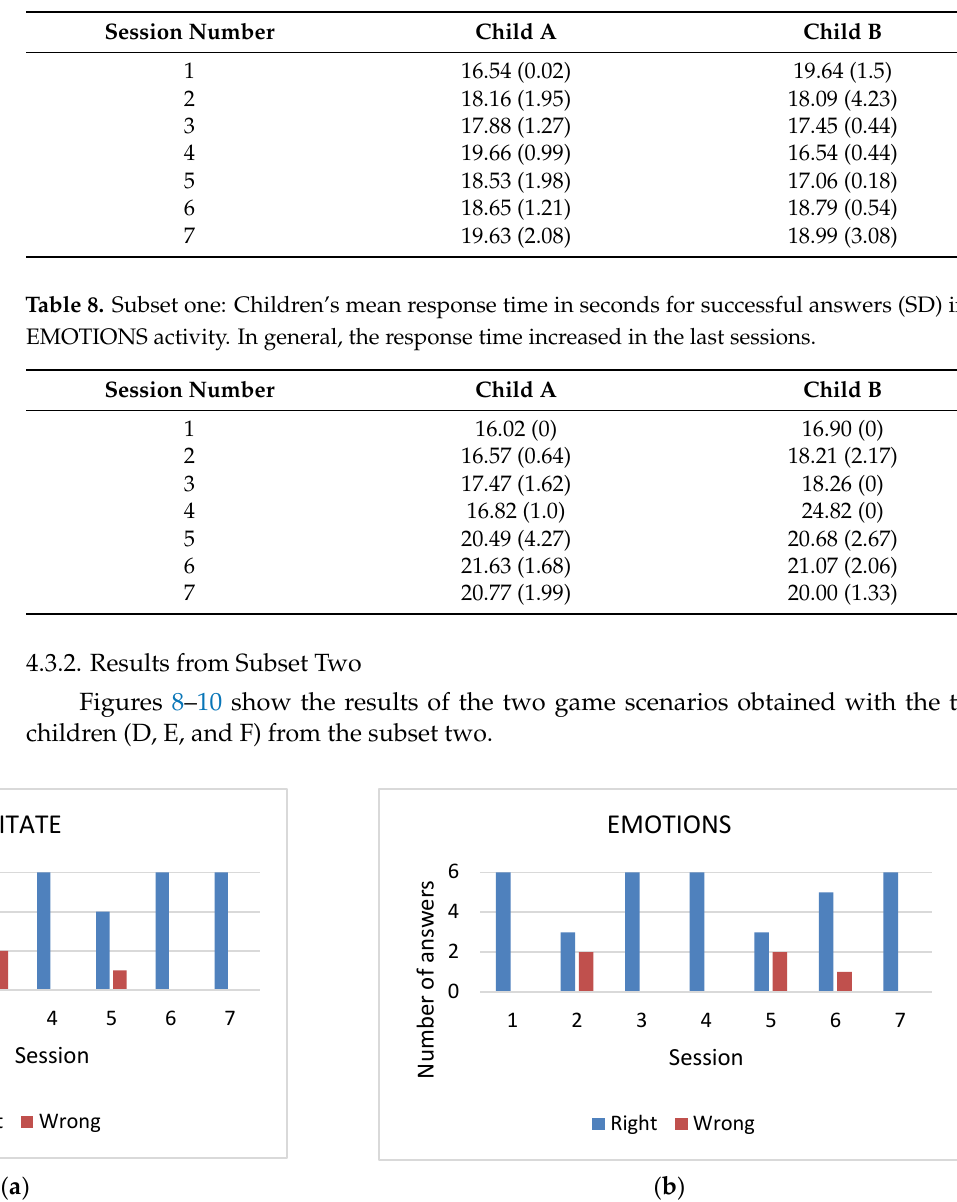
Table 7. Subset one: Children’s mean response time in seconds for successful answers (SD) in the IMITATE activity. In general, the response time increased in the last session.